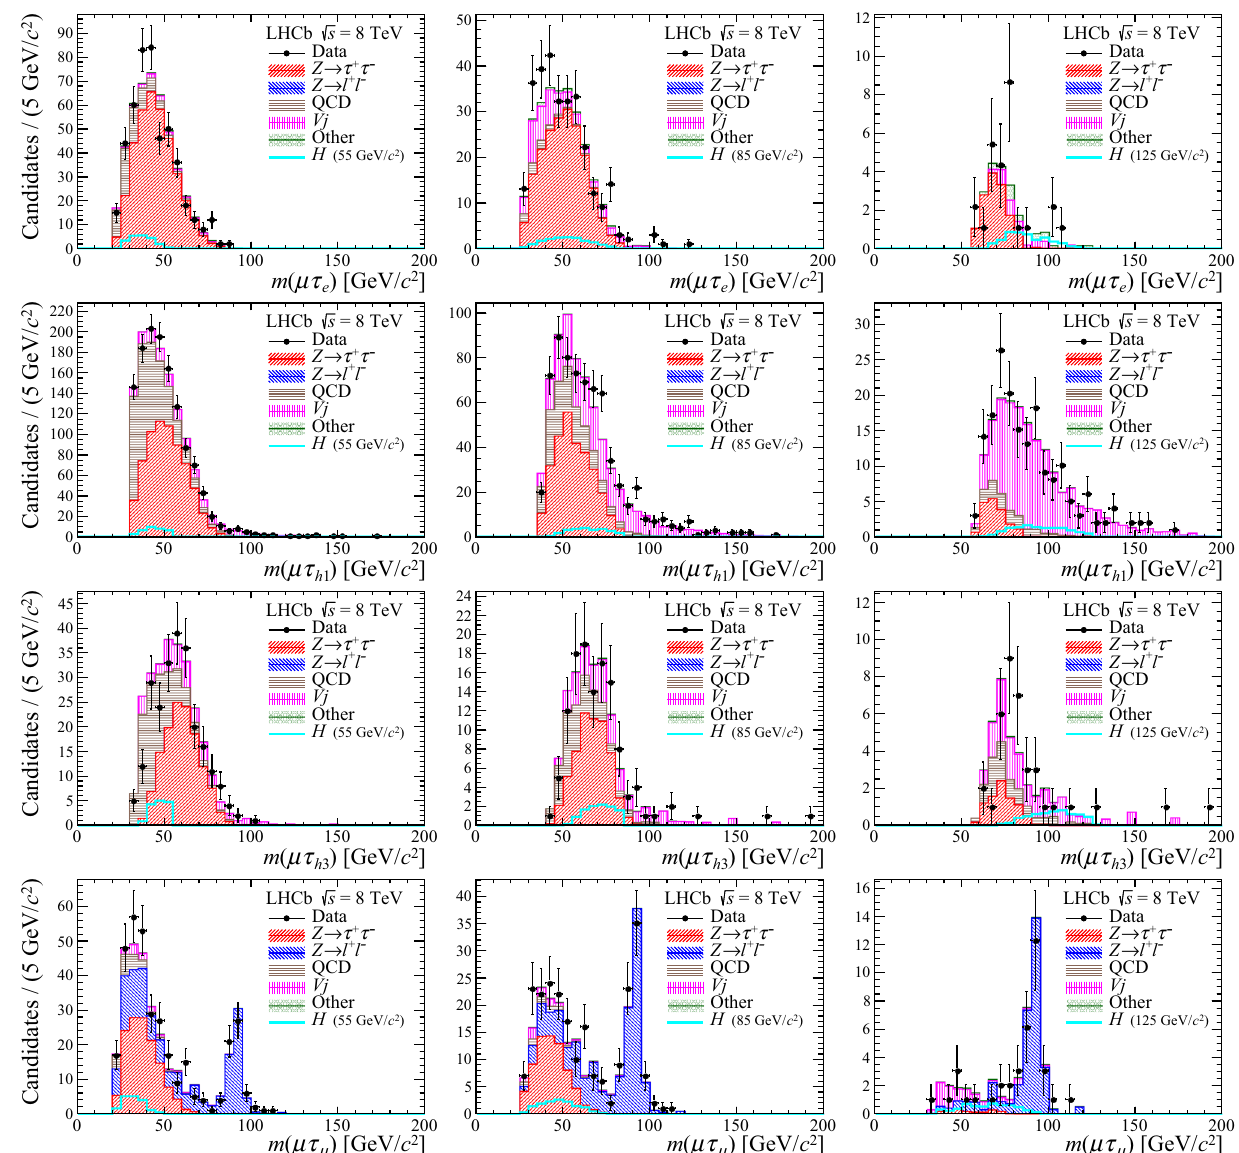
compared with backgrounds (filled colour, stacked), and with signal √ N , with N the total hypothesis (cyan). The signal is normalised to number of candidates in the corresponding data histogram